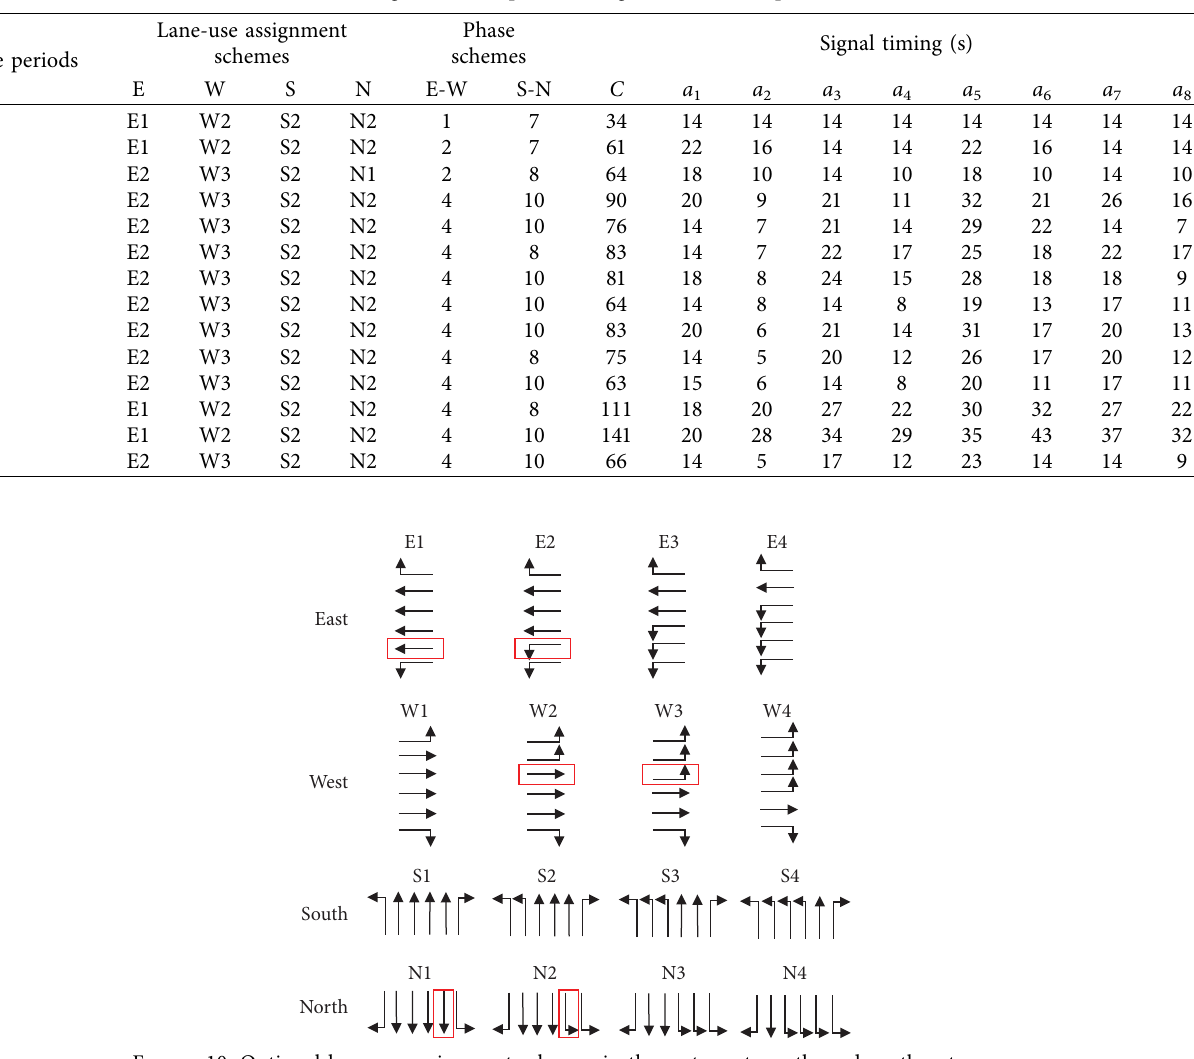
Table 7: Lane-use assignment and phase timing results of time periods of scheme E.